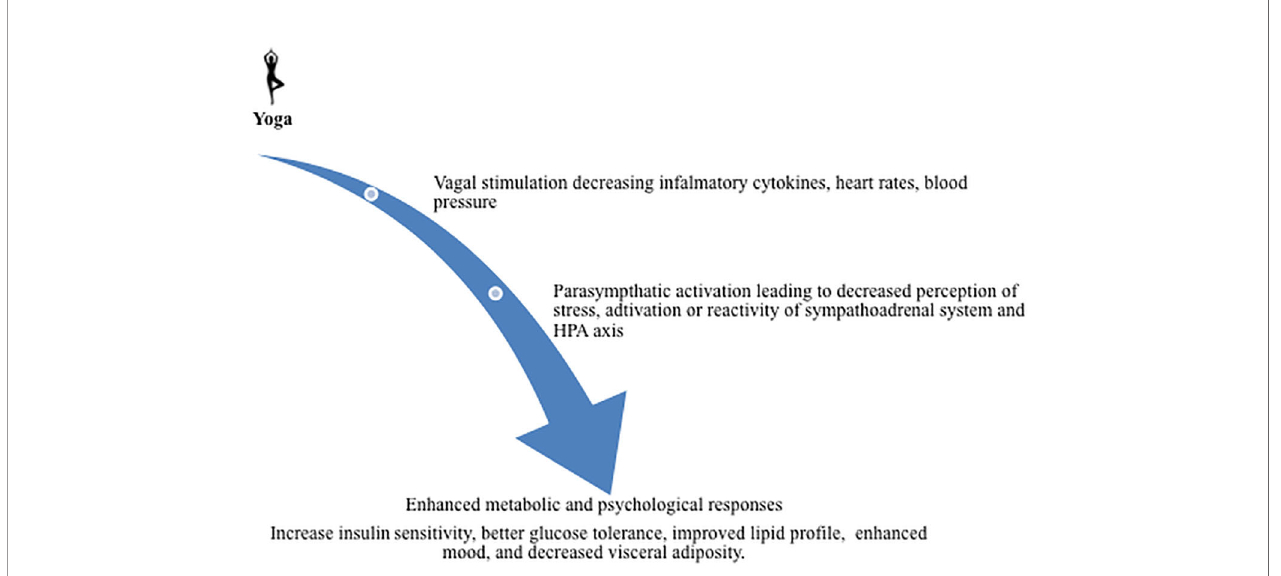
FIGURE 2 | Yoga bene fi t in decreasing diabetic risks: The studies show that yoga causes vagal stimulation and, therefore, decreases in fl ammatory cytokines and heart rate as well as blood pressure. The yoga activates parasympthatic system that possibly leads to decreased perception of stress, activation, or reactivity of the sympathoadrenal system and HPA axis. Further, it may enhance metabolic and psychological responses, insulin sensitivity, glucose tolerance, improved lipid pro fi le, mood, and decreased visceral